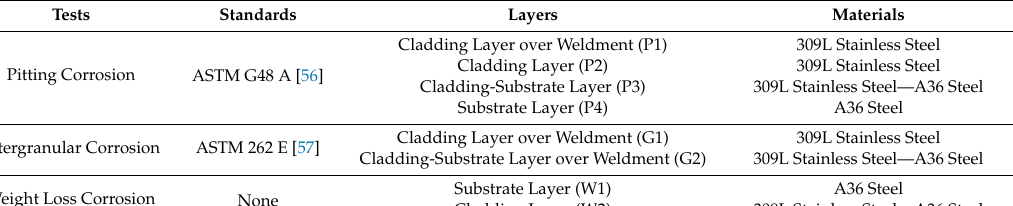
Table 6. Considered conditions in the corrosion tests.